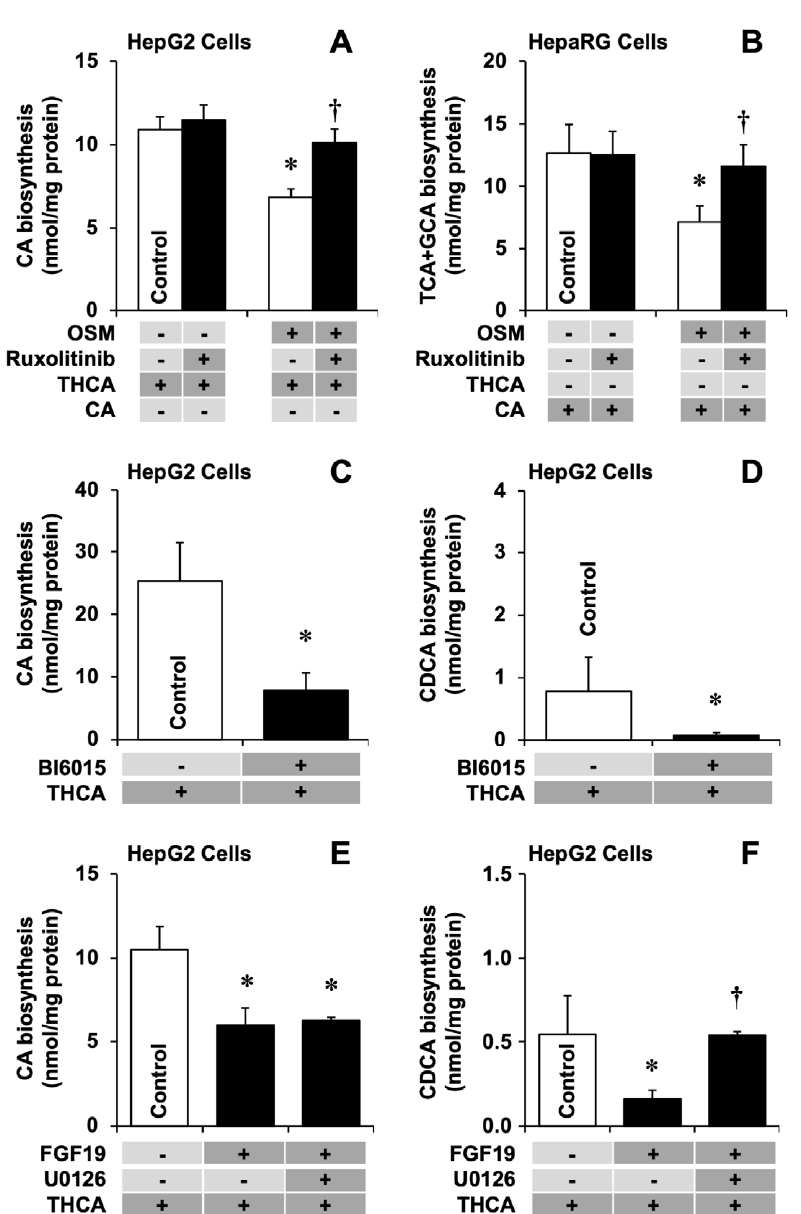
Figure 3. Effect of oncostatin M (OSM, 25 ng/mL) in the absence or presence of the JAK inhibitor ruxolitinib (0.5 µ M) on cholic acid (CA) biosynthesis from trihydroxycholestanoic acid (THCA, 10 µ M) by HepG2 cells ( A ) and taurocholic acid (TCA) plus glycocholic acid (GCA) biosynthesis from CA (5 µ M) by differentiated HepaRG cells ( B ). Effect of the HNF4 α inhibitor BI6015 (5 µ M) on the ability of HepG2 cells to biotransform exogenous THCA (10 µ M) into CA ( C ) and generate chenodeoxycholic acid (CDCA) from endogenous dihydroxycholestanoic acid ( D ). Effect of recombinant human FGF19 (50 ng/mL) alone or in the presence of the MEK1/2 inhibitor U0126 (5 µ M) on the ability of HepG2 cells to biotransform exogenous THCA (10 µ M) into CA ( E ) and to generate CDCA from endogenous dihydroxycholestanoic acid ( F ). After the initial 6 h in the absence of BA substrates, THCA or CA were added and maintained for the following 48 h. BA content in the culture medium and cell lysates was then analyzed. Results (mean ± SD) from six determinations that were carried out in three different cultures. BA species were measured by HPLC-MS/MS. *, p < 0.05, as compared to Control by paired t -test. †, p < 0.05, as compared with cells incubated in the absence of the inhibitor used in each group by paired t